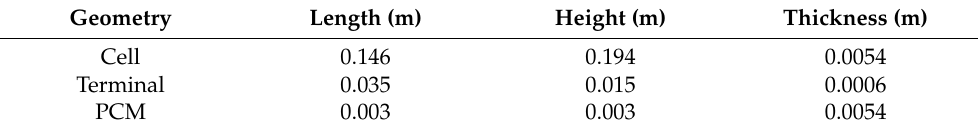
Table 4. Dimensions of the battery and PCM geometry in the simulations of Javani et al. [28].